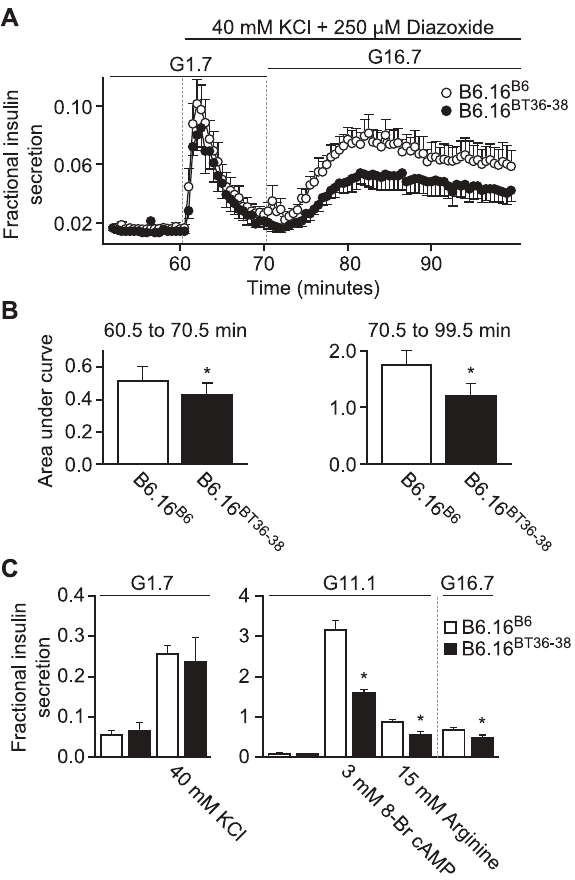
Figure 5. Impaired insulin secretion in islets isolated from the B6.16 BT36–38 mice. Islets were isolated from 10-week male control B6.16 B6 mice (open circles) or B6.16 BT36–38 mice (filled circles). A) Islets were preincubated for 60 min in low glucose (1.7 mM) and basal